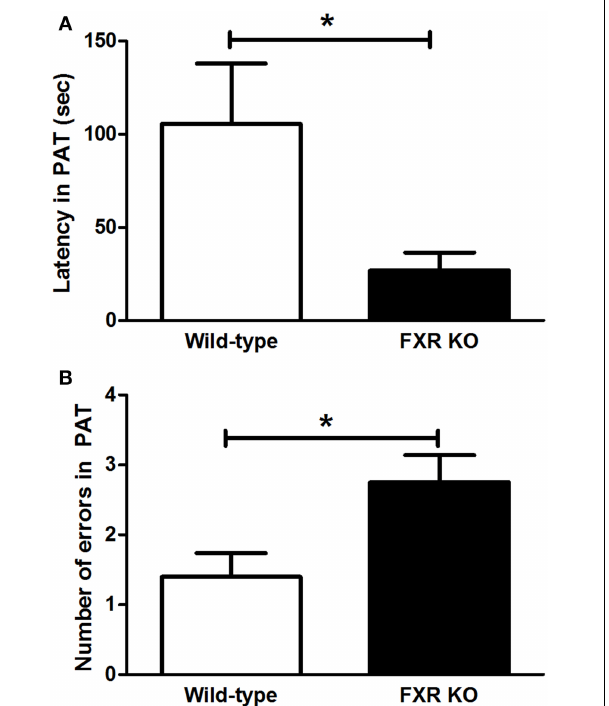
FIGURE 4 | FXR KO impaired cognitive ability of the mice. In comparison with wild-type controls, FXR KO mice displayed decreased latency (A) but increased number of errors (B) in PAT. N = 12 /group; * p < 0 . 05